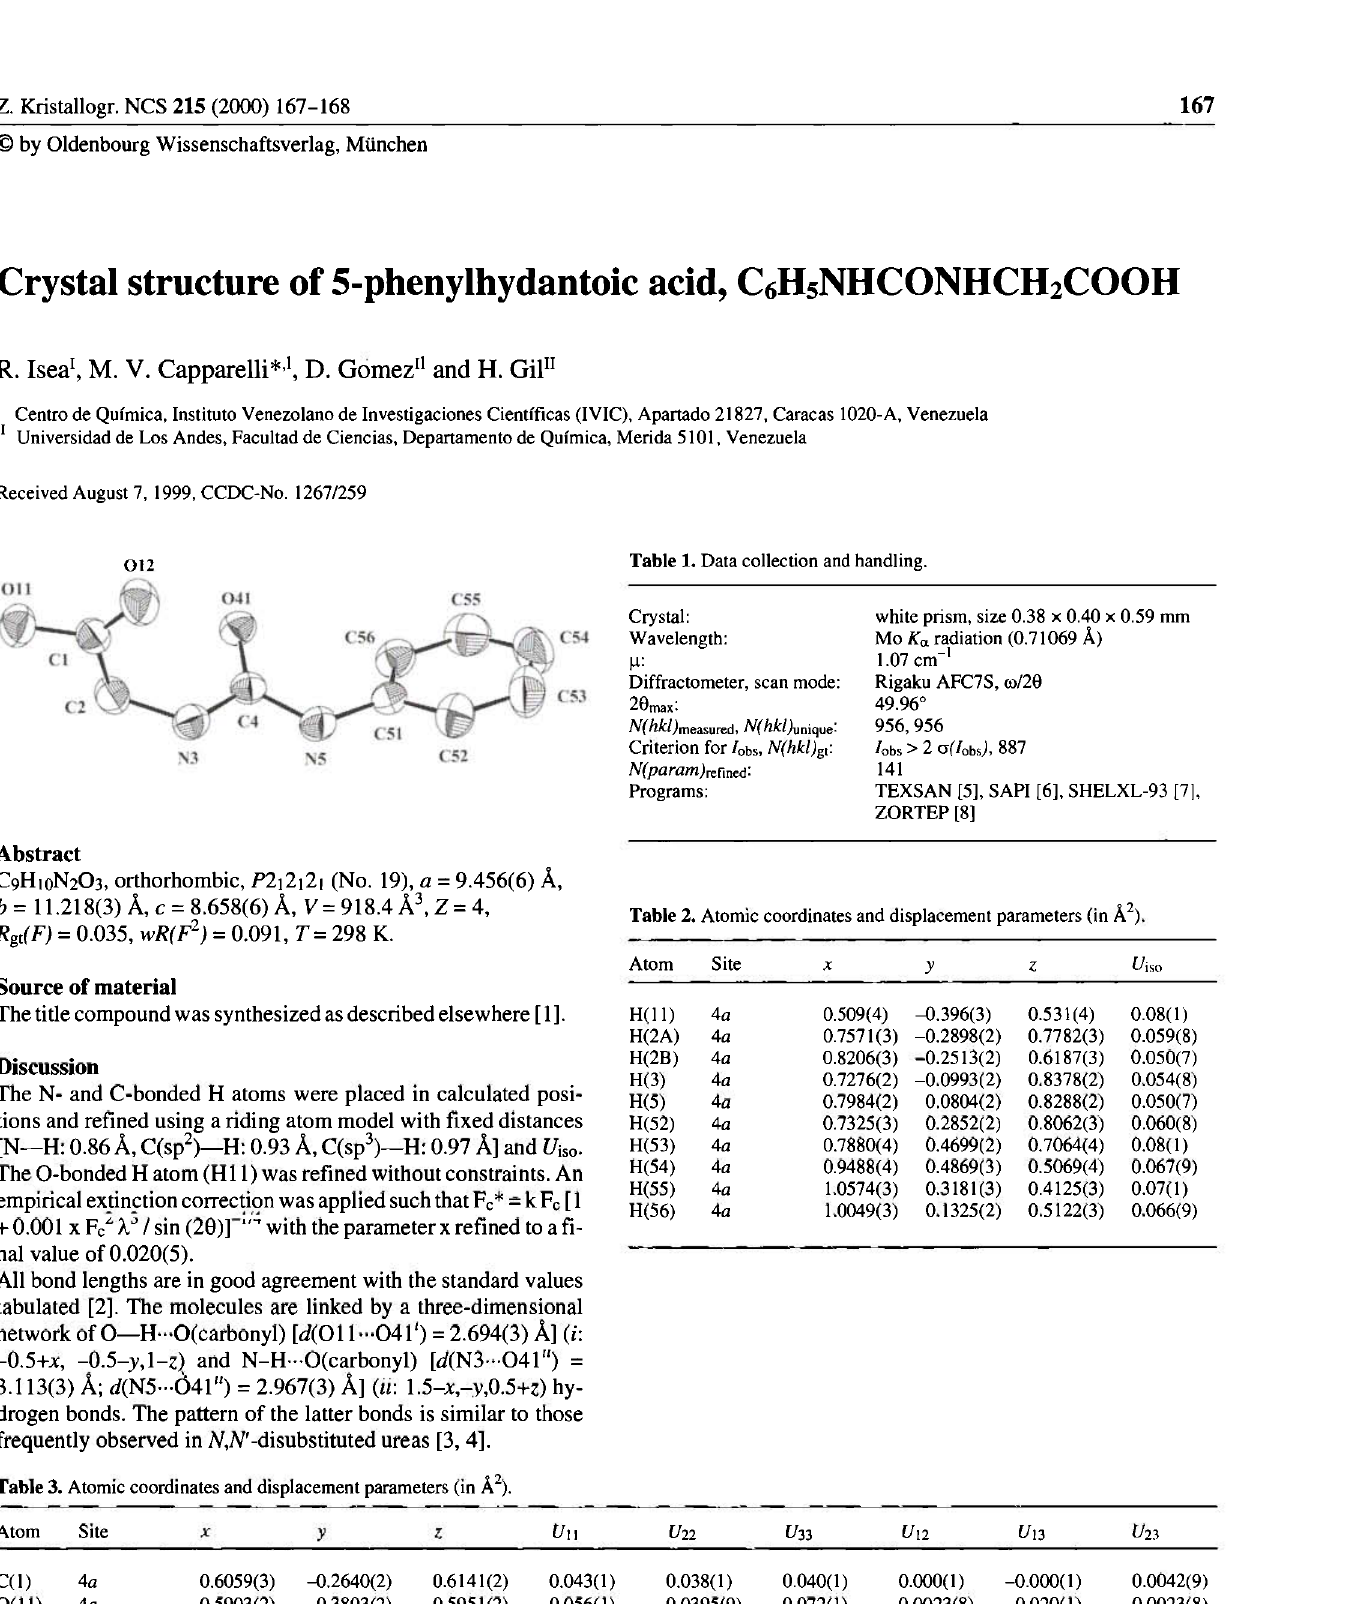
Table 3. Atomic coordinates and displacement parameters (in Ä 2 ).